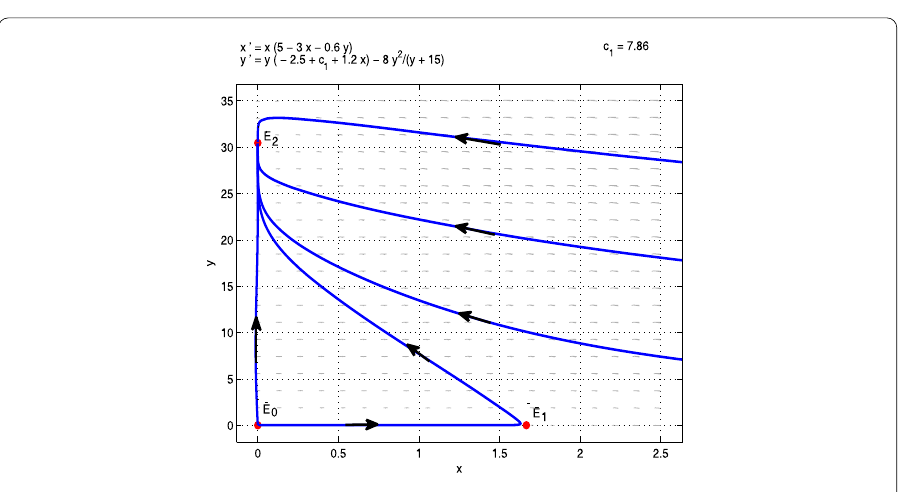
Figure 6 Dynamic behaviors of system (4.2) if c 1 =